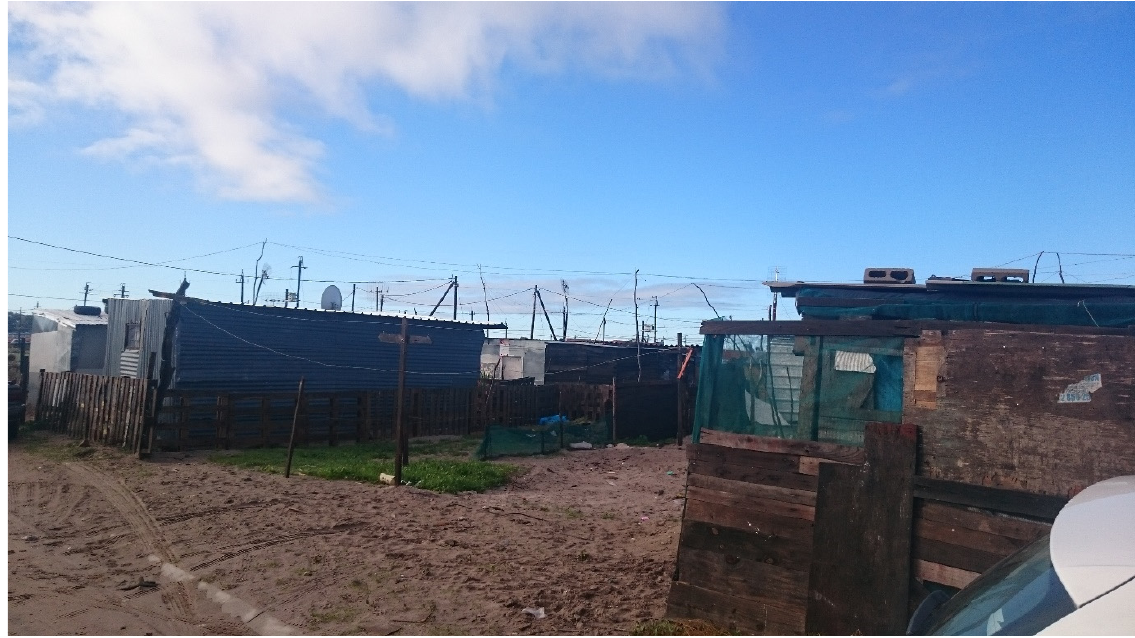
Figure A2. Atlantis Witsand informal settlement in 2015, Western Cape, South Africa.